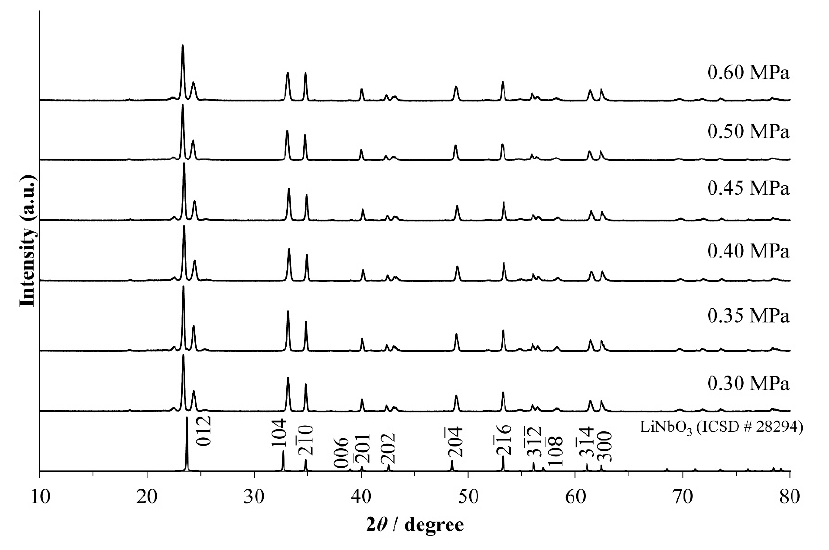
Figure 1. XRD patterns of Li 1+ x - y Nb 1- x -3 y Ti x +4 y O 3 (LNT) solid solutions with Ti 20 mol % at 1373 K for 30 min under various air pressures.